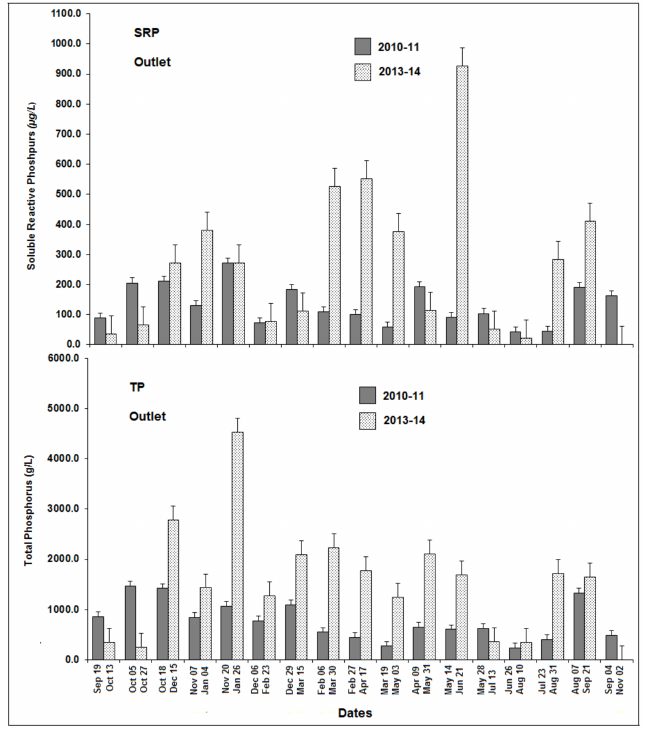
Figure 9. Soluble reactive phosphorus (SRP) and total phosphorus (TP) concentrations ( µ g/L) measured at the lagoon’s outlet from 19 August 2010 to 4 September 2011 and from 13 October 2013 to 2 November 2014.